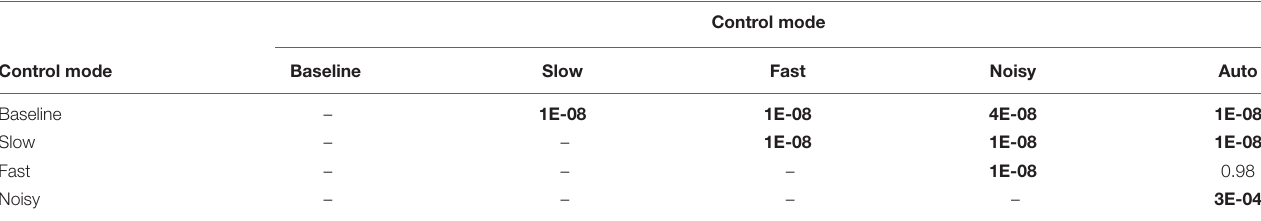
Figure 9D . A linear regression on that data indicates a positive relationship (slope > 0, p < 0.05) between correction sensitivity and agency.